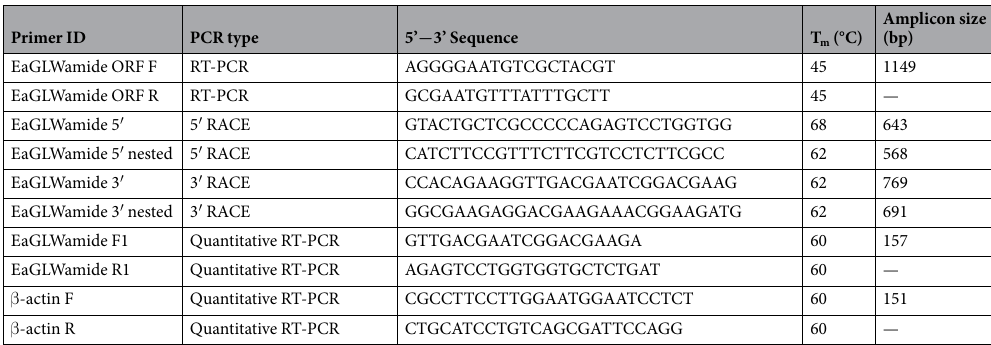
Table 1. List of primers. aF and R primers were paired for reverse-transcription PCR (RT-PCR). Rapid amplification of cDNA ends (RACE) primers were nested, with primer 1 used before primer 2 in the sequential amplification